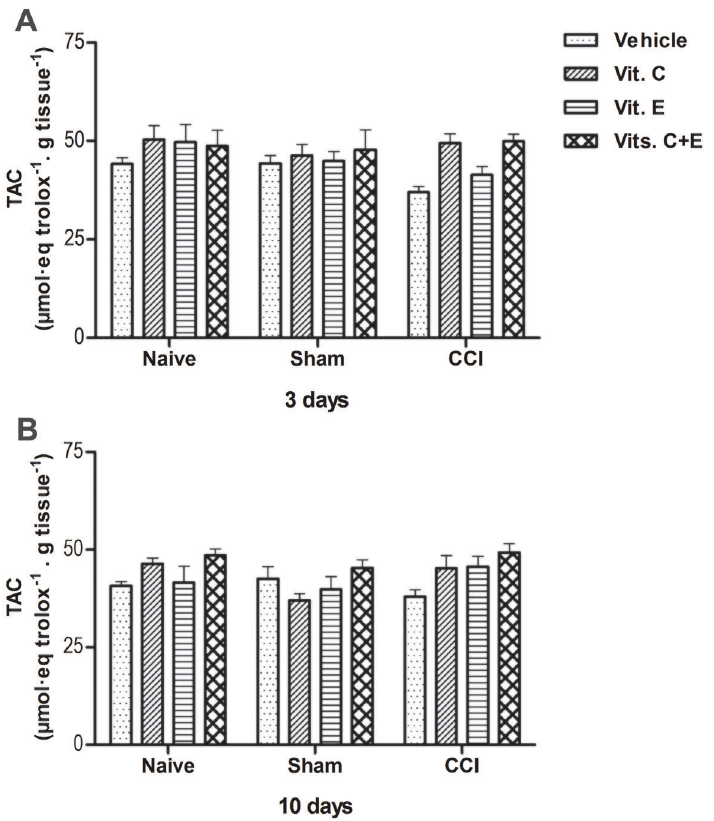
Figure 3. Total antioxidant capacity (TAC) in the spinal cord of rats treated with vit. C (30 mg (cid:1) kg – 1 (cid:1) day – 1 ), vit. E (15 mg (cid:1) kg – 1 (cid:1) day – 1 ), a com- bination of these vitamins (vits. C + E) in the same doses, or the vehicle alone (saline contain- ing 1% Tween 80) administered intraperitoneally for 3 ( A ) and 10 ( B ) days after chronic constric- tion injury (CCI). Data are reported as means ± SE (n=6/group). No statistical difference between groups was found (two-way ANOVA followed by Tukey post hoc